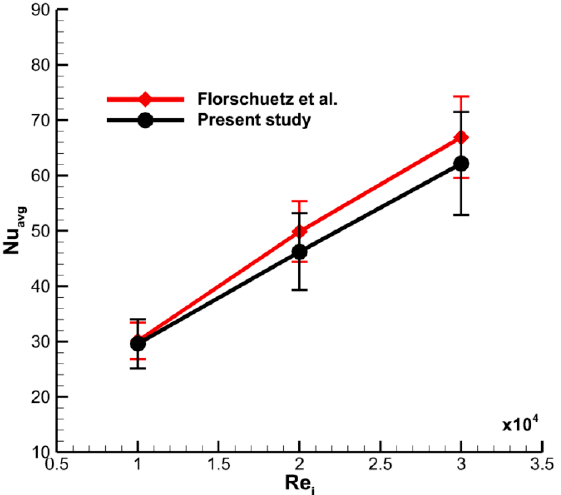
Figure 5. Area-averaged Nu from measurements and correlation of Florschuetz et al. [35].